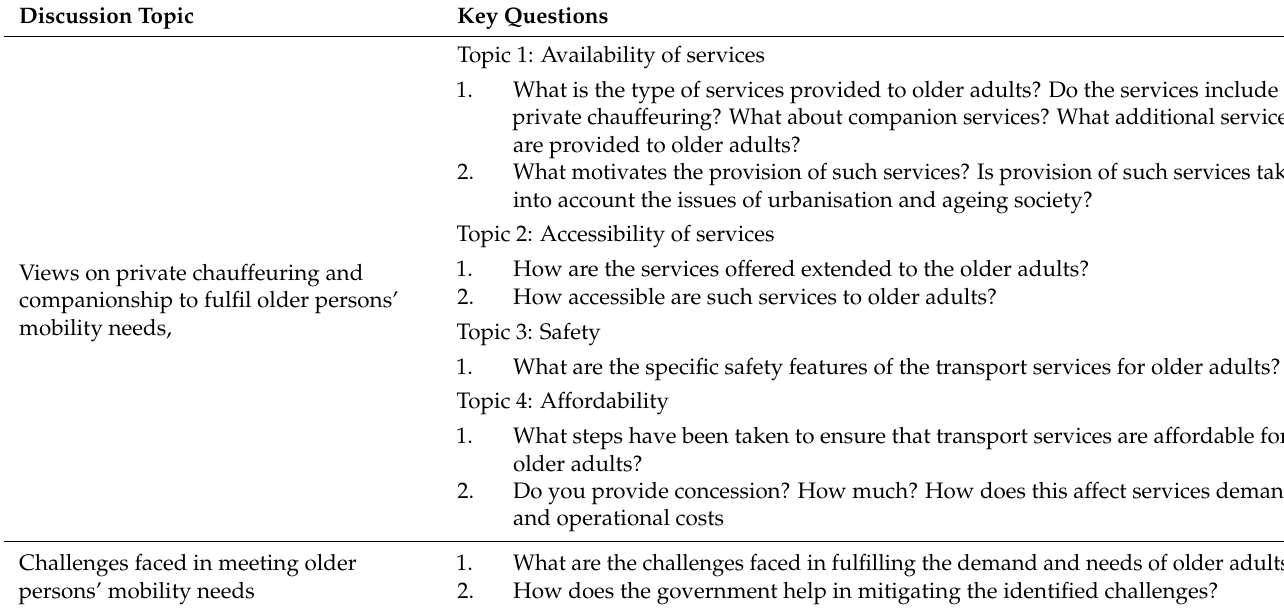
Table 1. Discussion topics and their respective key